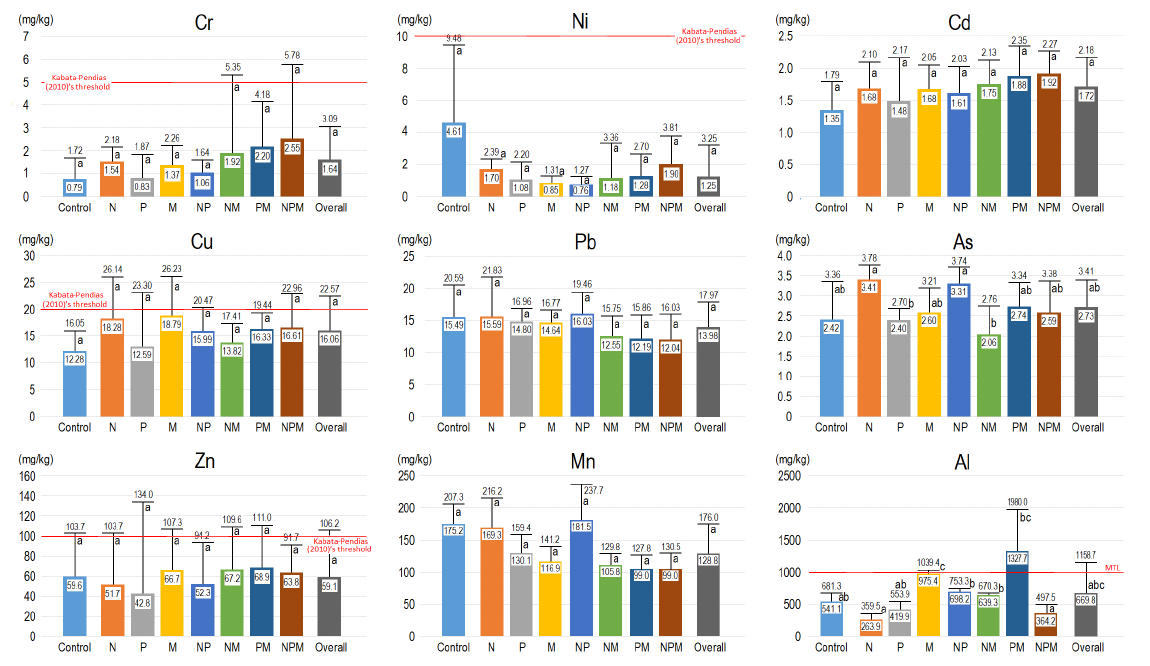
Figure 3. Metal levels of the above-ground biomass of bermudagrass under 25% sludge loading rate and different fertilization treatments in VS. (Note: N.D. = not determined due to insufficient amount of sample for analysis. Error bars indicate the 95% confidence interval. Different letters denote the statistical difference.)